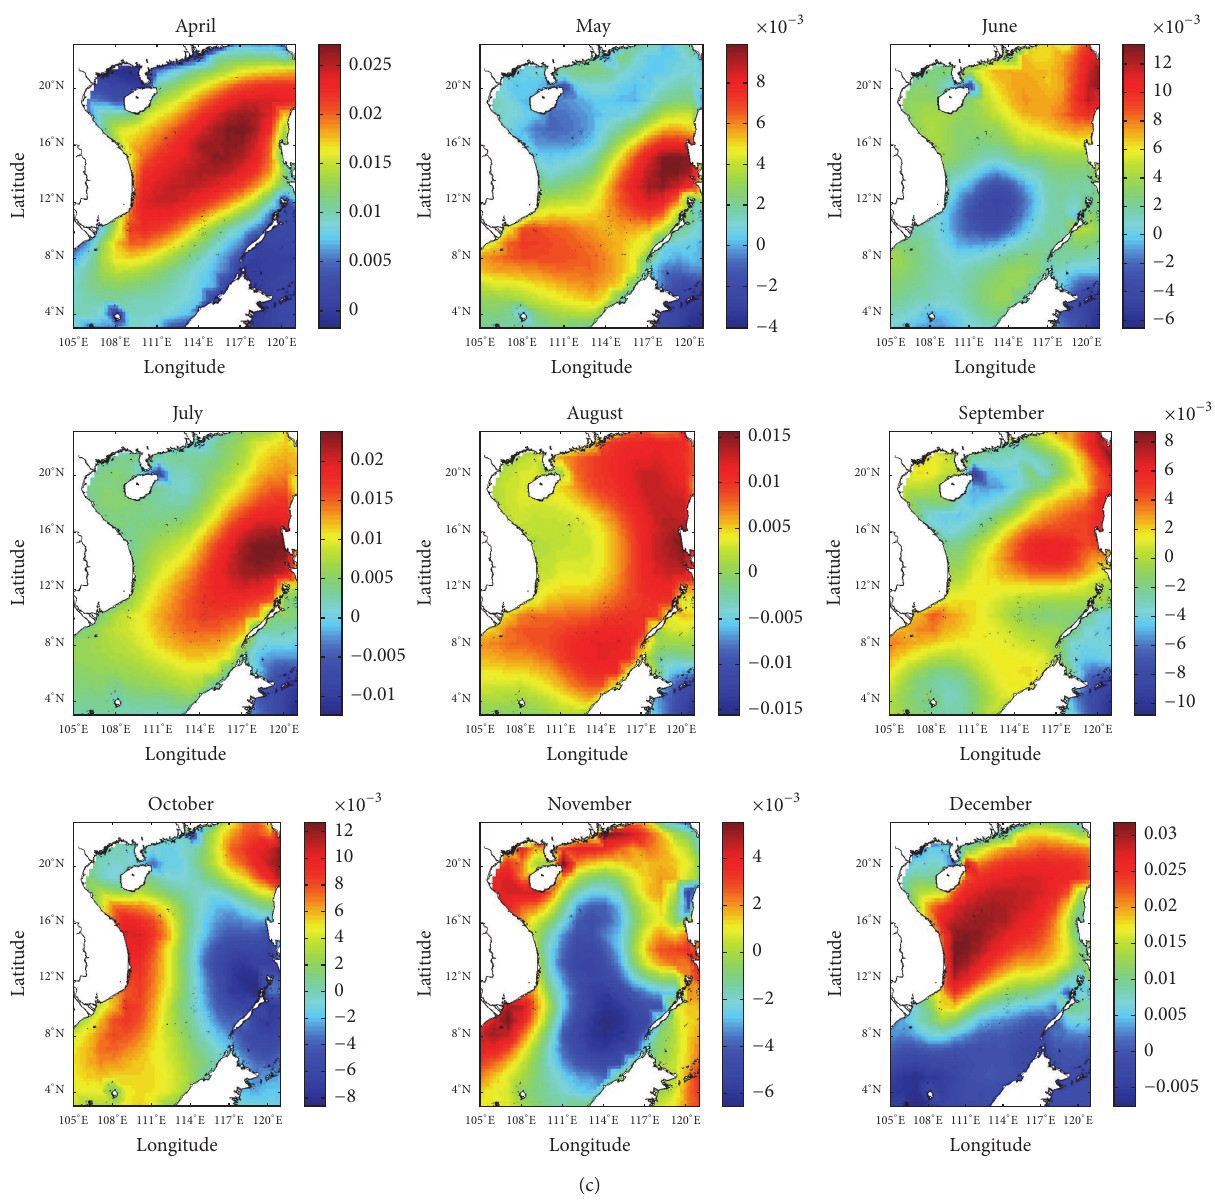
Figure 5: (a) Long-term trend of annual mean SWH from year 1976 to year 2005. Unit: m yr −1 . Only trends significant at the 95% level are shown. (b) Long-term trends of seasonal mean SWH from year 1976 to year 2005. Unit: myr −1 . Only trends significant at the 95% level are shown. (c) Long-term trends of monthly mean SWH from year 1976 to year 2005. Unit: myr −1 . Only trends significant at the 95% level are